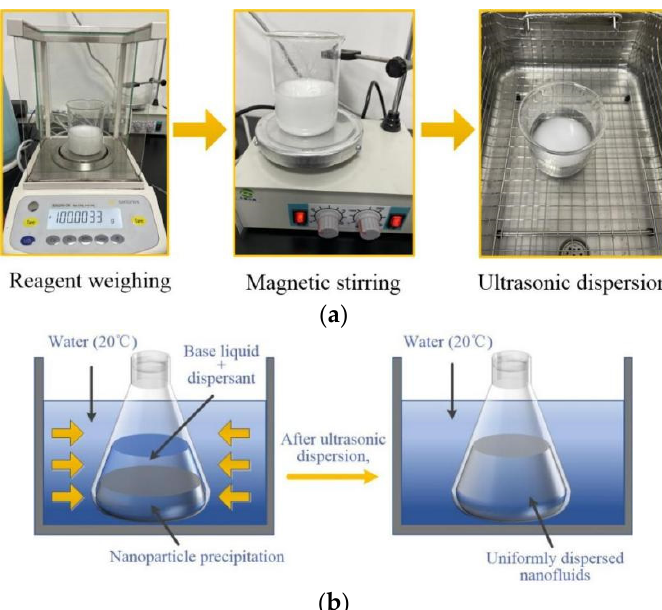
Figure 2. Analysis of experimental materials. ( a ) The photo of TEM. ( b ) Particle size distribution of experimental dust sample.